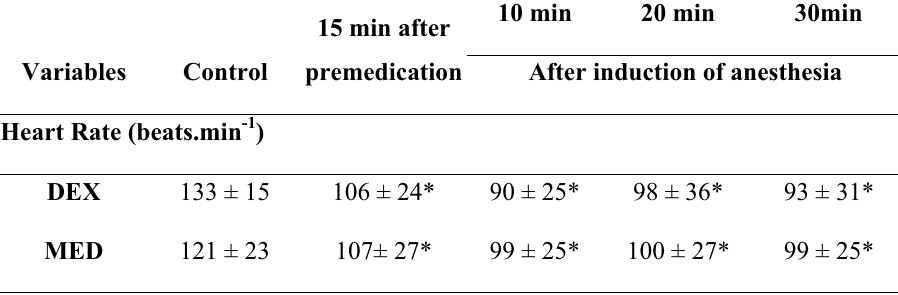
TABLE 2 – Respiratory and Oxygenation Parameters of dexmedetomidine group (DEX) and medetomidine group (MED) at the times of